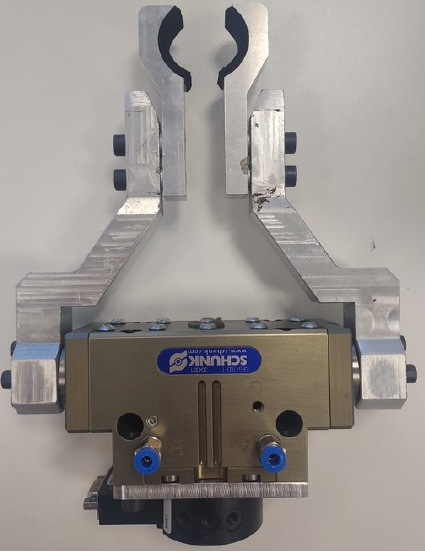
Figure 2. The pneumatic gripper used for grasping the detected